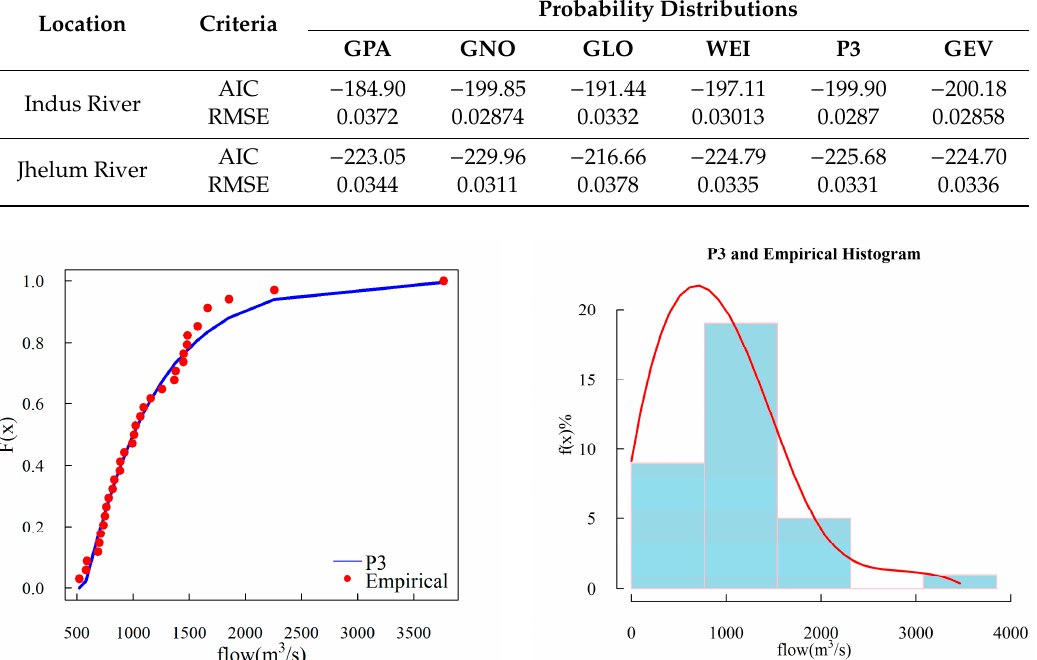
Figure 4. Distribution and empirical histogram of historical data fitted by P3 distributions for Indus river.